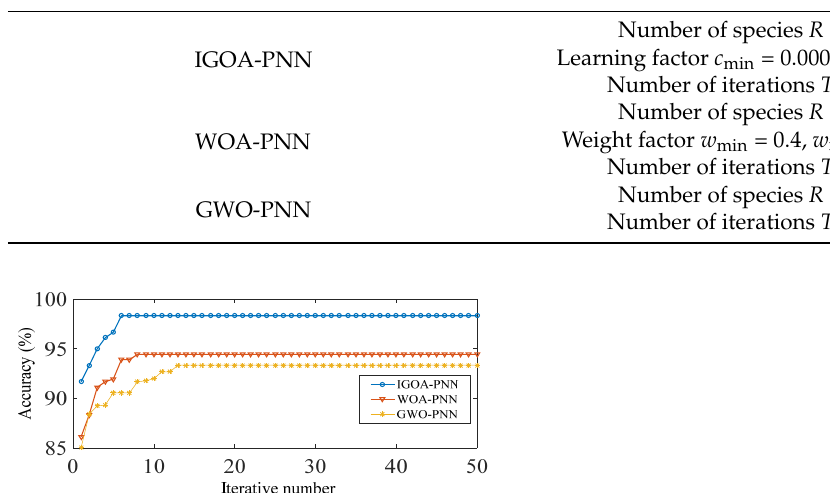
Figure 13. The recognition accuracy curves of different algorithms. Table 2. Main parameters of different algorithms.